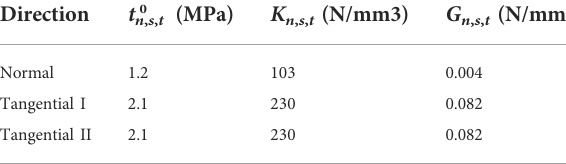
FIGURE 14 Constitutive model of cohesive element.